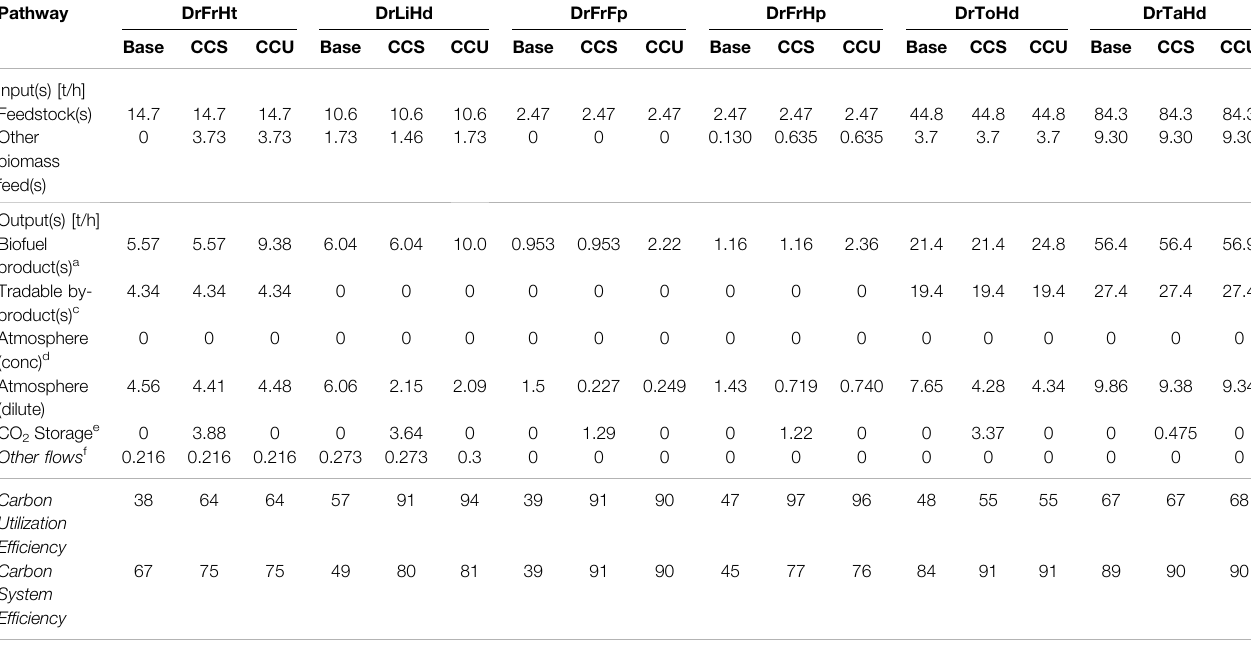
TABLE 7 | Biogenic carbon fl ows for hydrotreatment pathways: DrFrHt, DrLiHd, DrFrFp, DrFrHp, DrToHd and DrTaHd. See Table 1 for explanation of pathway abbreviations. Pathway DrFrHt